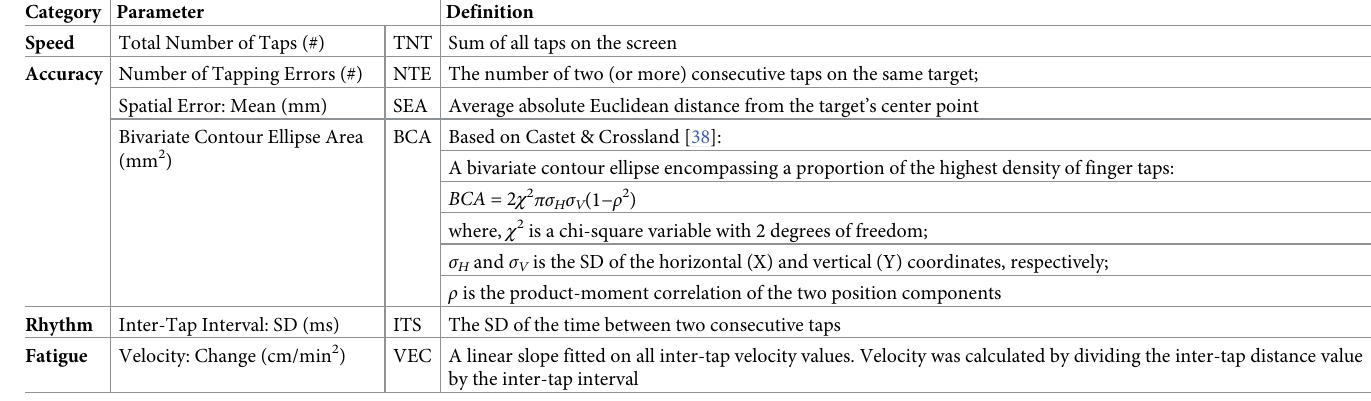
Table 2. Tapping task